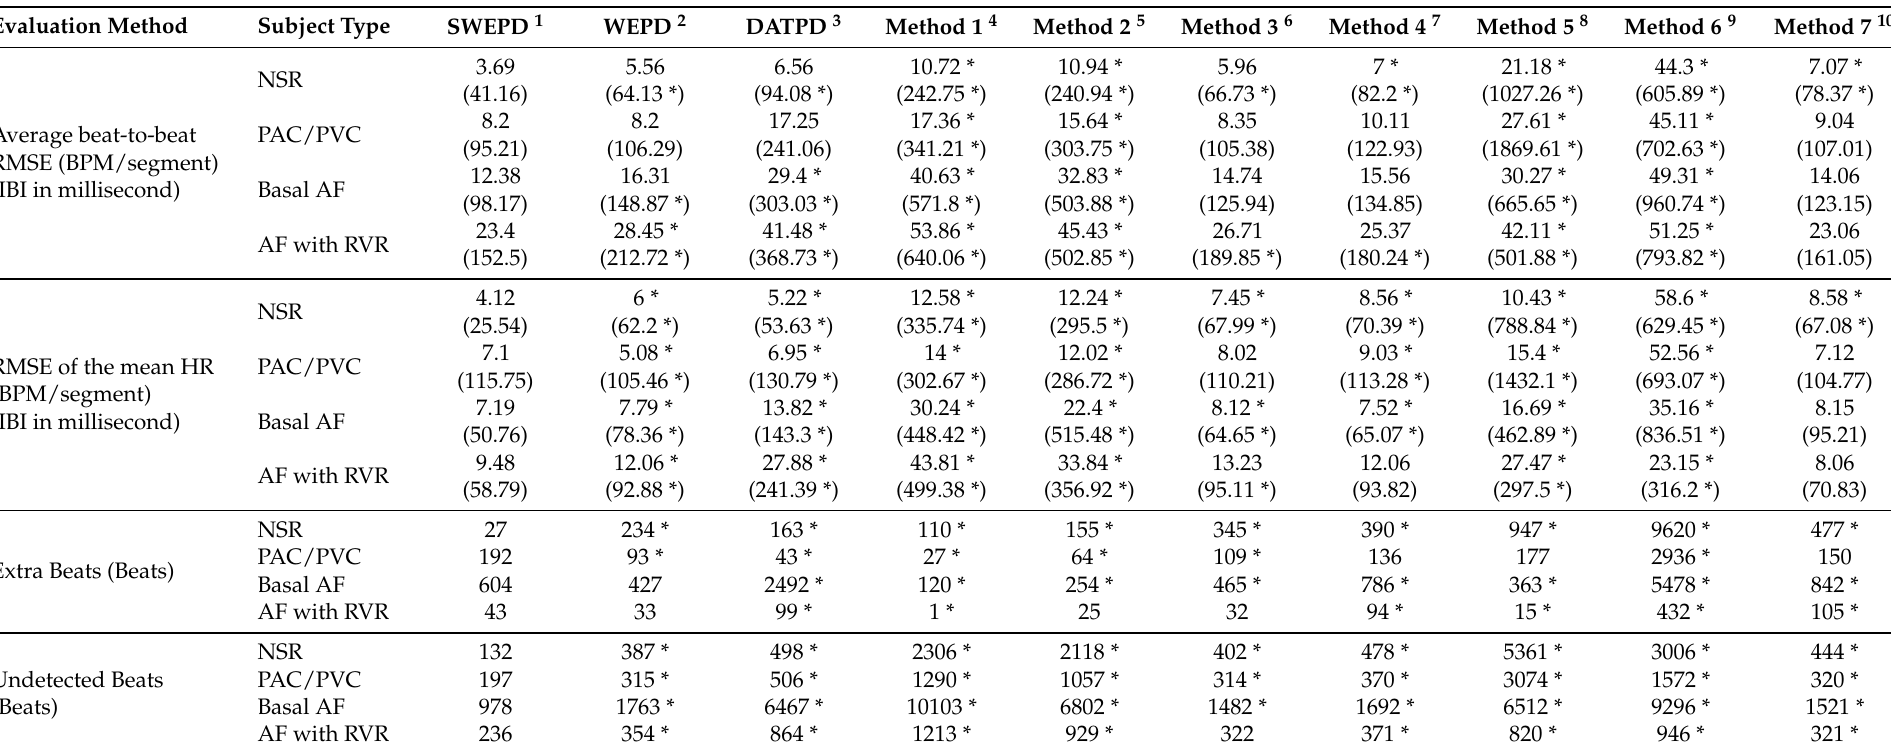
Table 3. Evaluation of Proposed Peak Detection Methods on Independent Testing Dataset (Samsung Gear S3 and Samsung Galaxy Watch